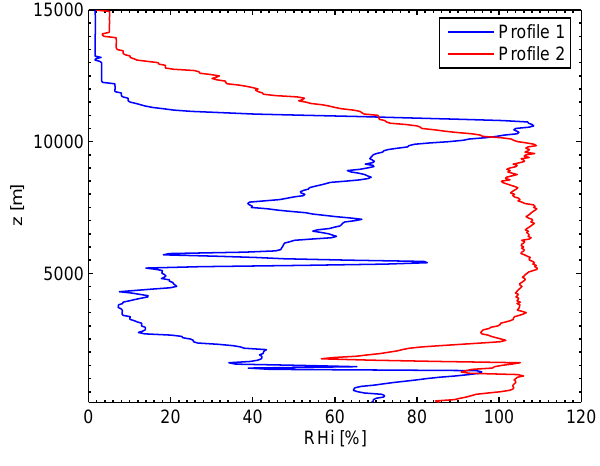
Fig. 10. Profile 1: steep upper RHi gradient (Lindenberg 1 July 2000 06:00UTC); Profile 2: weak upper RHi gradient (Lindenberg 4 March 2001 06:00UTC).